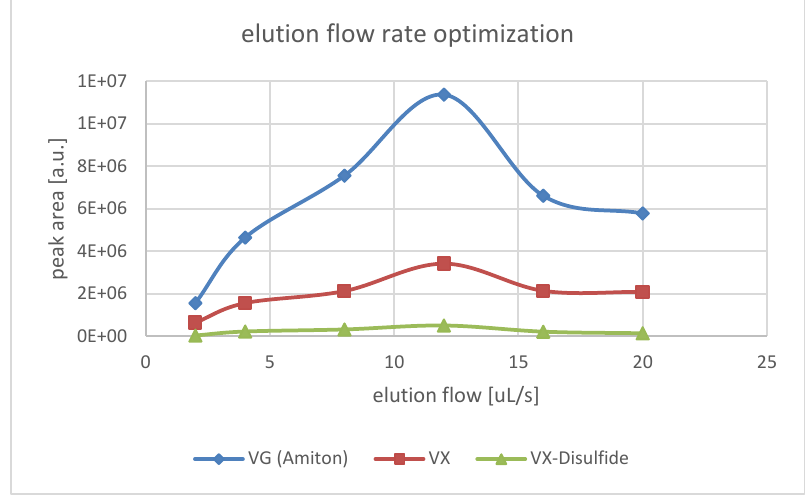
Figure 5. Representation of the elution flow rates and obtained peak areas in GC-MS for the different analytes on the silica µ-SPE cartridge.